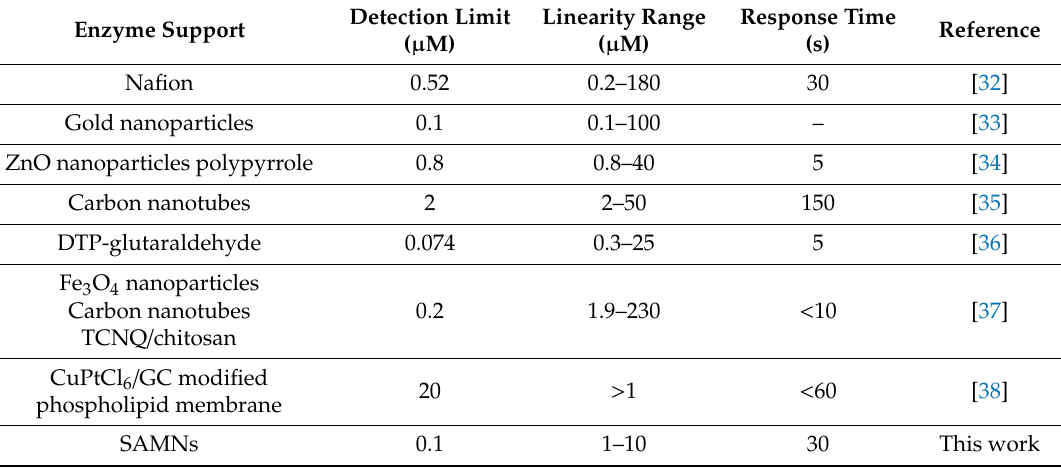
Table 2. Comparison among di ff erent xanthine detection reported in